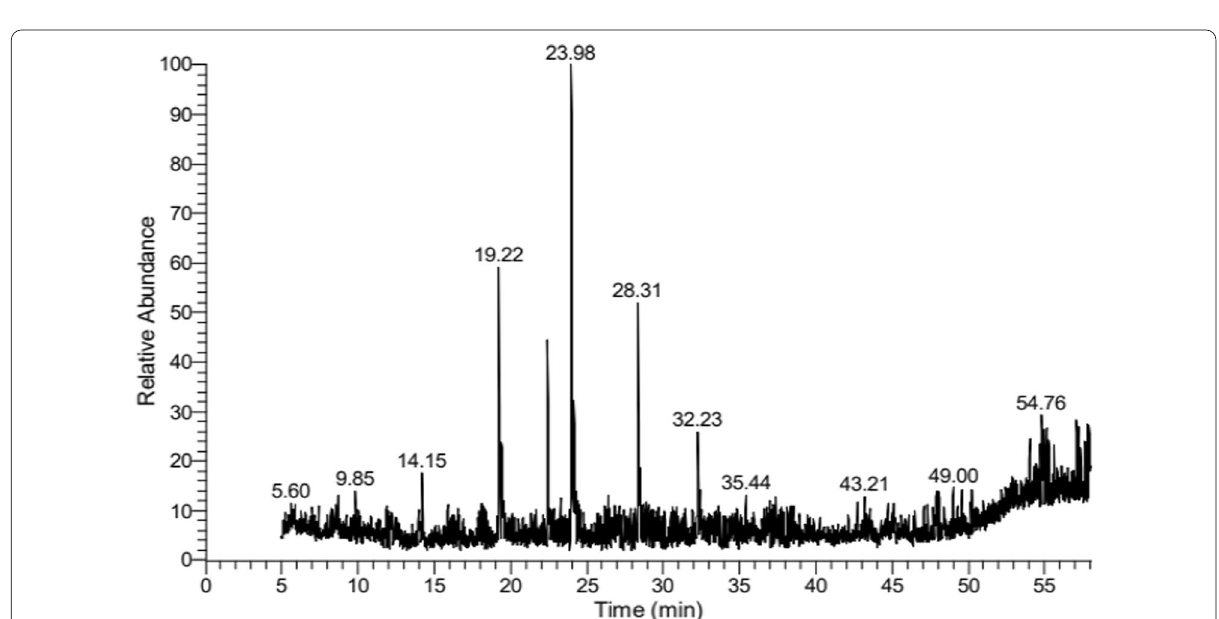
Fig. 1 HYPERLINK "sps:id::fig1||locator::gr1||MediaObject::0" GC/MS chromatogram of the methanolic extract of S. mahagoni